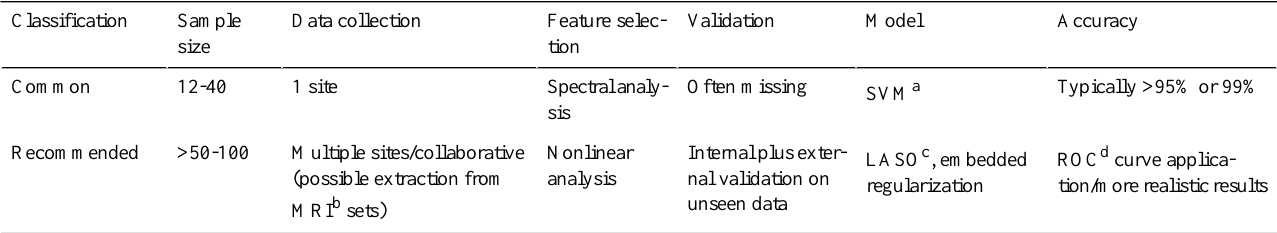
Table 3. Summary of the abovementioned comparisons with regard to the classifications